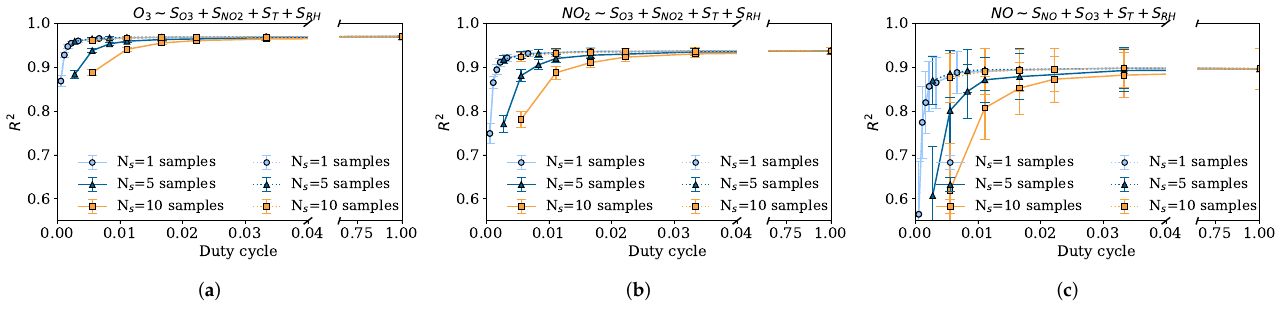
Figure 6. Average CV R 2 and 95% confidence intervals for different duty cycles with negligible sensor response time (T r ≈ 0) using MLR. Solid lines denote the strategy that samples the N s consecutively, and the dotted lines denote the strategy that samples the N s uniformly at T sen . ( a ) Captor 20001 O 3 CV R 2 for different duty cycles. ( b ) Captor 20001 NO 2 CV R 2 for different duty cycles. ( c ) Captor 20001 NO CV R 2 for different duty